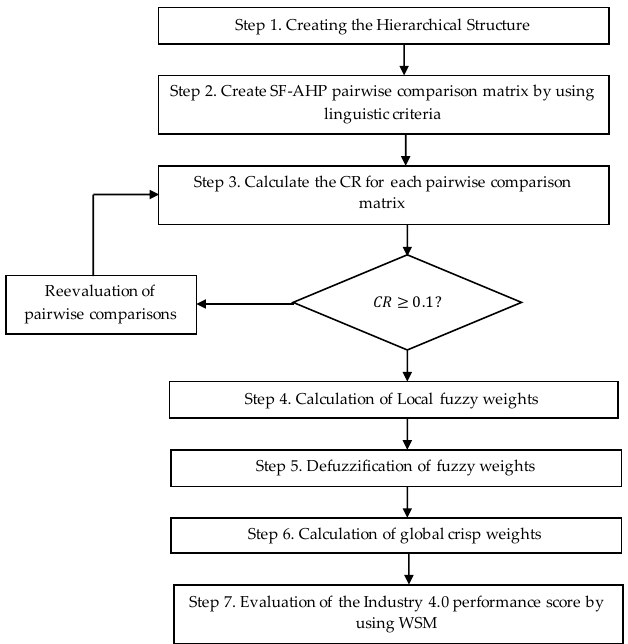
Figure 2. SF-AHP-WSM flow chart. Figure 2. SF-AHP—WSM flow